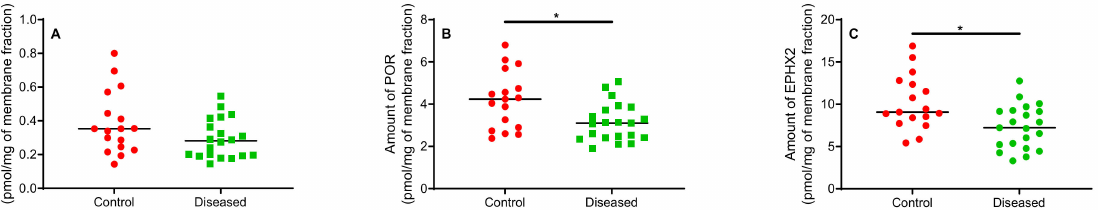
Figure 7. Quantitation of proteins involved in biosynthesis and degradation of EETs. Amounts of ( A ) CYP2J2, ( B ) POR, and ( C ) sEH proteins extracted from human cardiac tissue ( n = 17 for control tissue and n = 20 for diseased tissue). * indicates p ≤